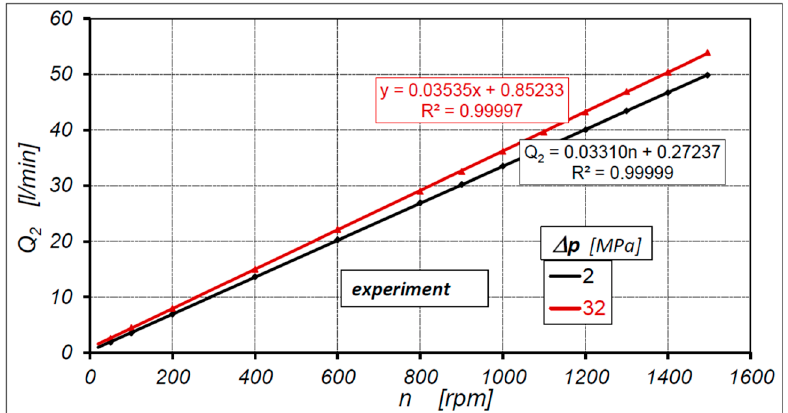
Figure 10. Characteristics of motor output flow rate Q 2 as a function of rotational speed n at p =